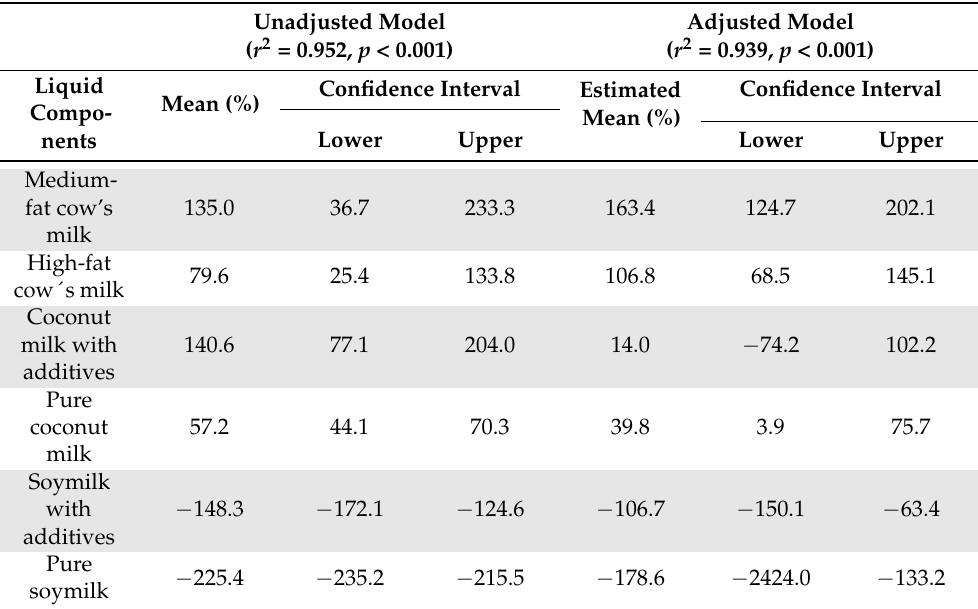
Table 3. Improvement in lutein liberation per gram of fat before and after adjustment for protein